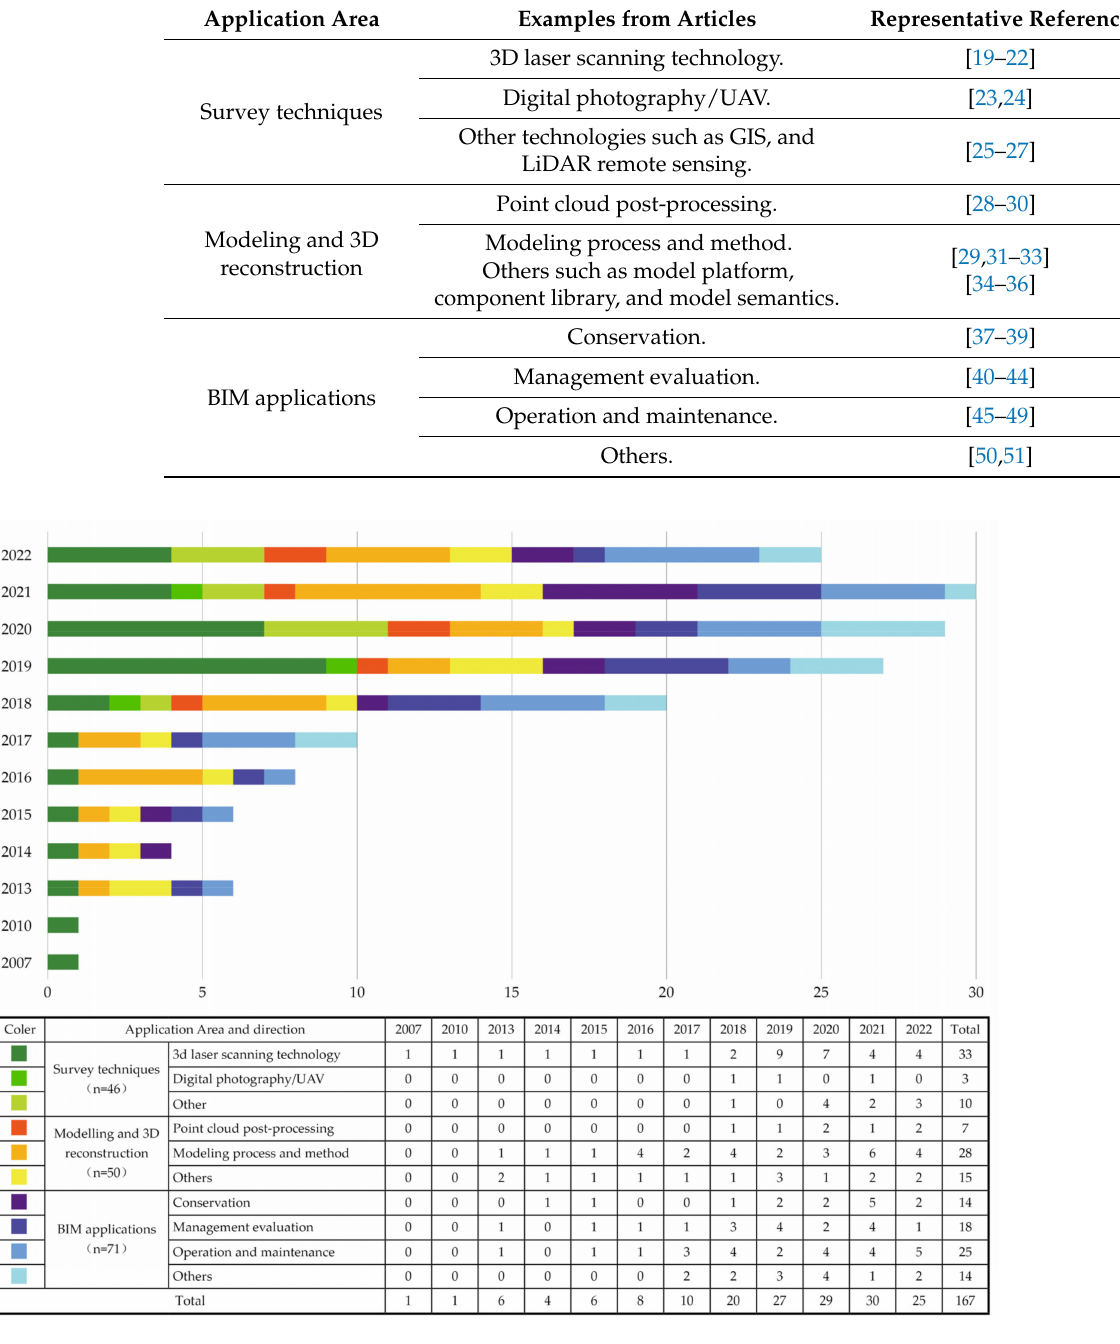
Figure 13. The number of articles published in different years from 2007 to 2022, divided into three subject